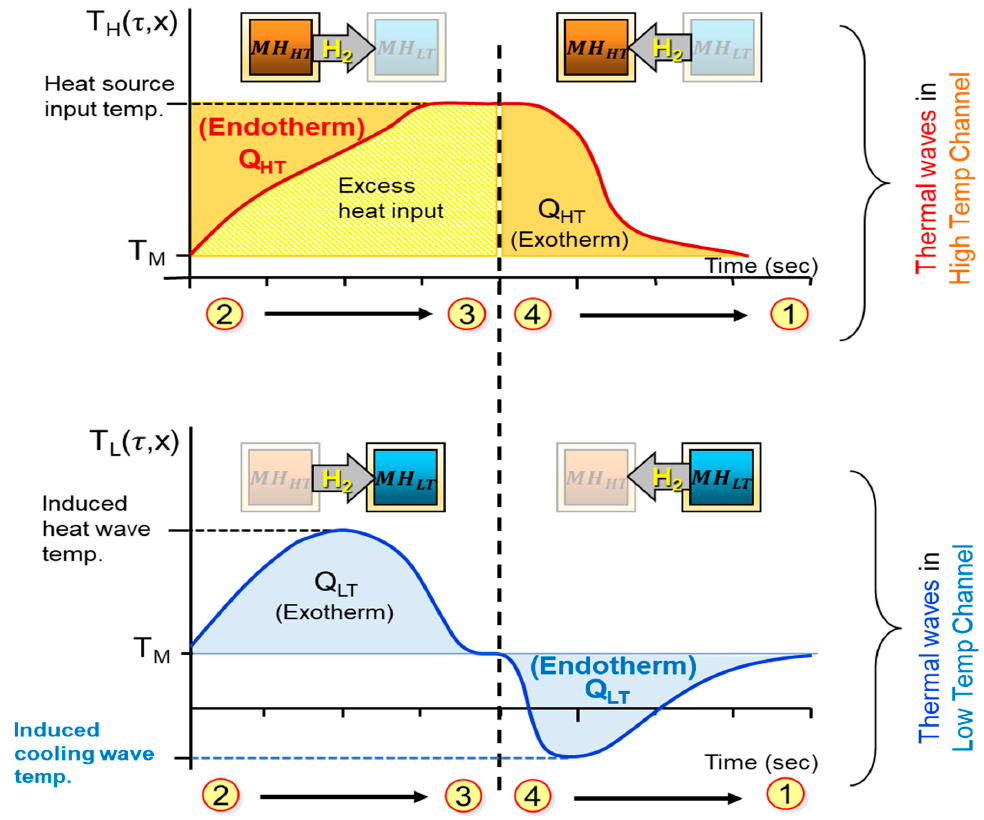
Figure 3. An illustration of thermal energy conversion wave (TECW) formation: TECW in red is from (cid:1839)(cid:1834) (cid:3009)(cid:3021) reactor ( top ); and TECW in blue is from (cid:1839)(cid:1834) (cid:3013)(cid:3021) reactor ( bottom ). The endotherm (cid:1843) (cid:3013)(cid:3021) is the MH HT reactor ( top ); and TECW in blue is from MH LT reactor ( bottom ). The endotherm Q LT is the objective cooling load in the cooling system. objective cooling load in the cooling